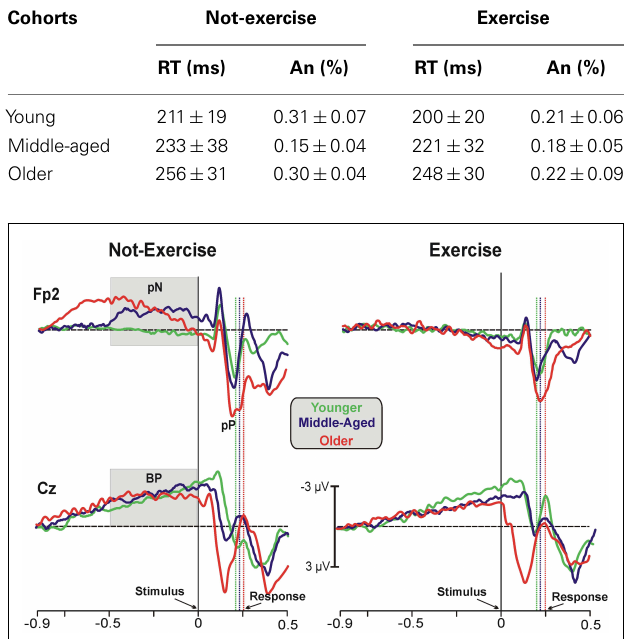
than middle-aged (4.32 ± 0.4 µ V) and younger (4.04 ± 0.4 µ